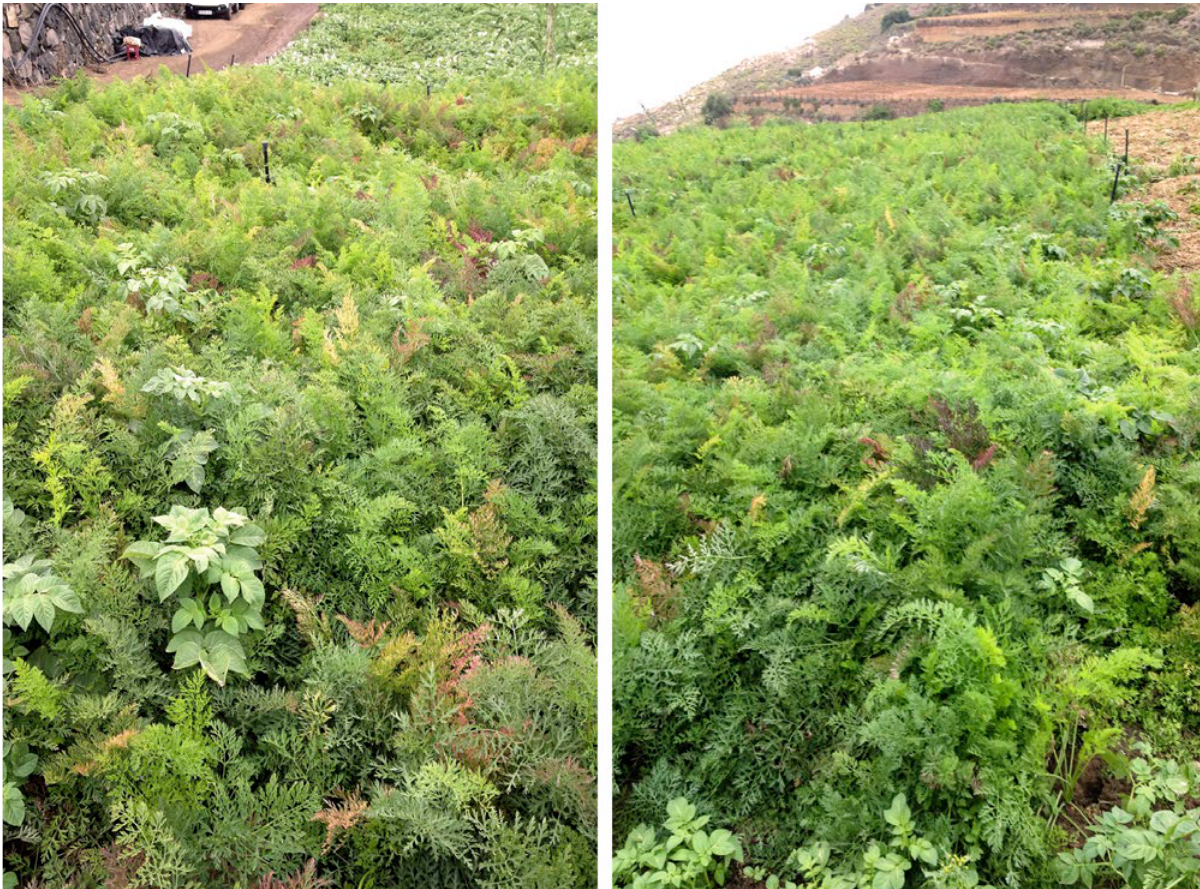
Figure 1. Two fields showing disease symptoms in carrot (variety Cordoba), in Guía, Gran Canaria Island